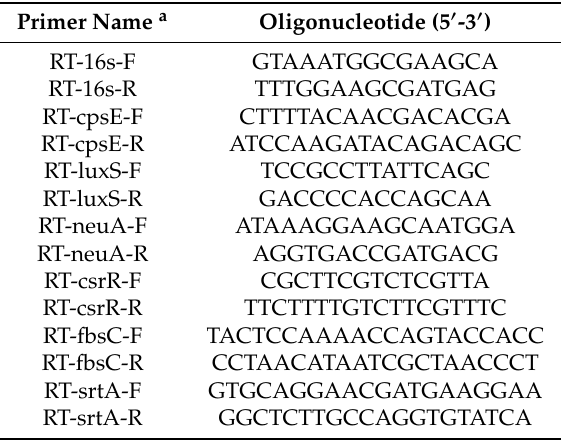
Table 1. Oligonucleotide primers used in this